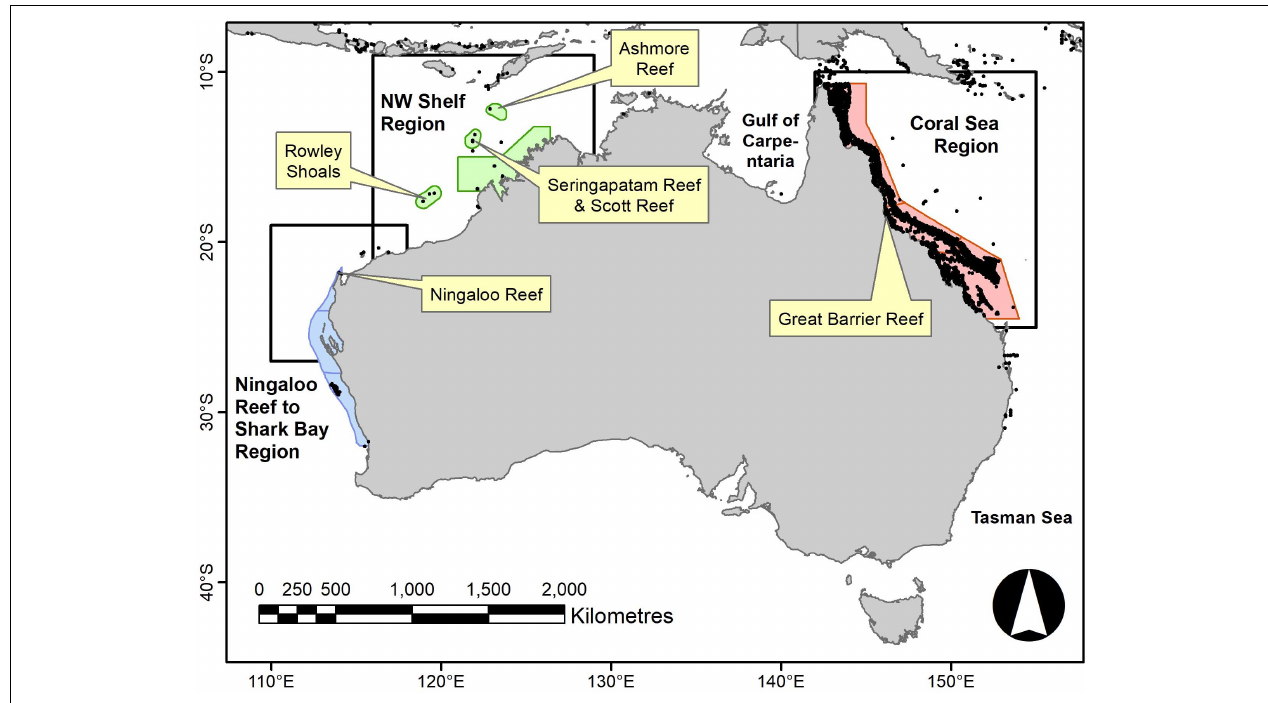
FIGURE 1 | Coral reef regions around Australia included in the thermal stress assessment. Blue grouping denotes reefs on the west coast of WA, green denotes those on the Northwest (NW) Shelf, and red shading encompasses the GBR Marine Park. Reef location data from Tupper et al. (2011).